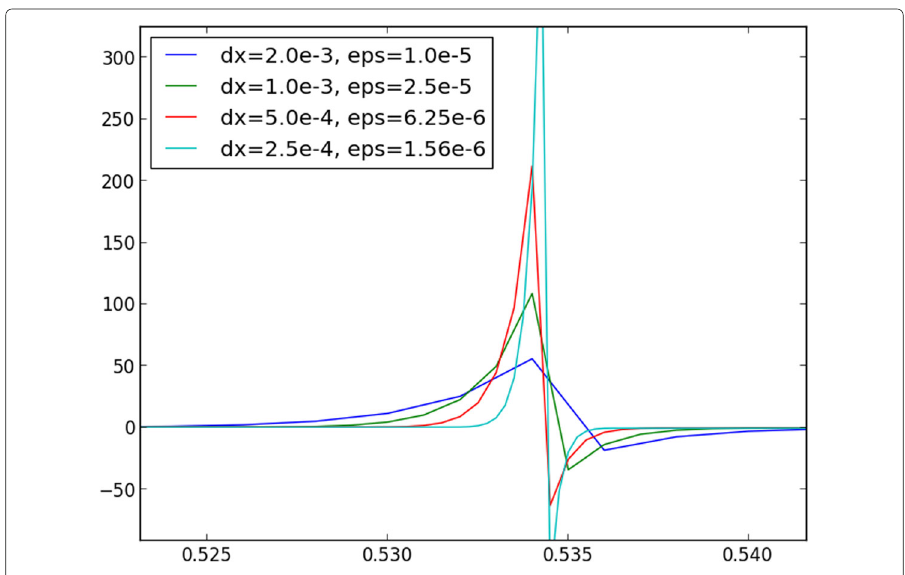
Fig. 4 Delta-shock convergence. (Color online) Close-up of the delta defects as dx , (cid:6) → 0,